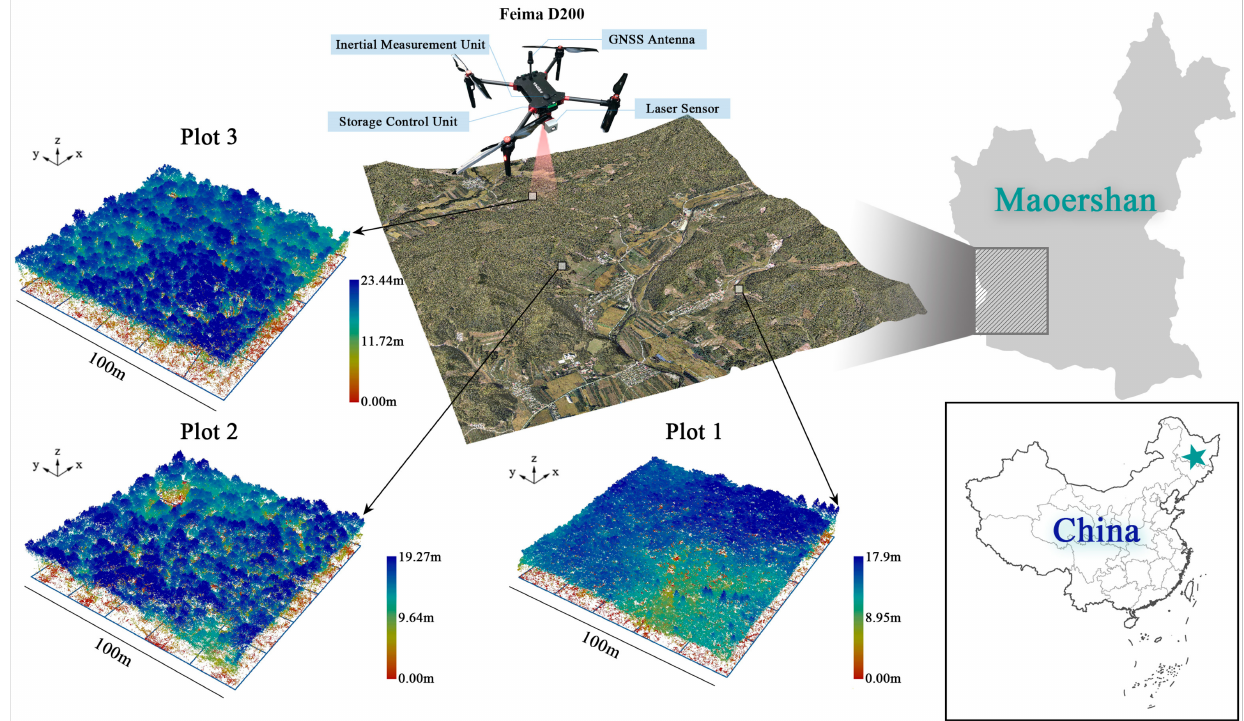
Figure 2. Location of the study area and distribution of UAVLS